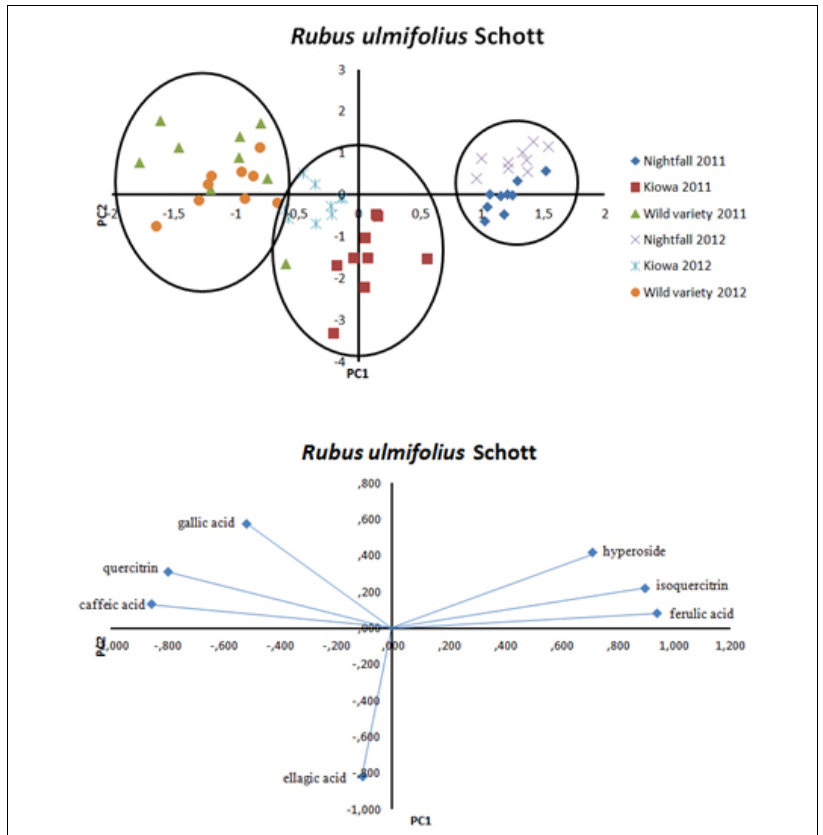
Fig. 7: Rubus ulmifolius : PCA individual and variable graph of University bud-preparation